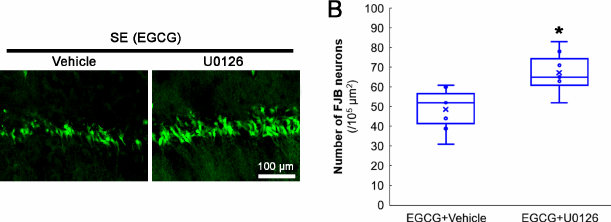
Figure 8. E ff ects of ERK1/2 inhibition by U0126 co-treatment on SE-induced neuronal damage in CA1 neurons of EGCG-treated rats. Compared with the vehicle, U0126 co-treatment abolished the protective e ff ect of EGCG on SE-induced neuronal degeneration. ( A ) Representative FJB-positive- degenerating CA1 neurons following SE. ( B ) Quanti fi cation of the number of FJB-positive neurons (* p < 0.05 vs. vehicle co-treatment; n = 7 rats, respectively).